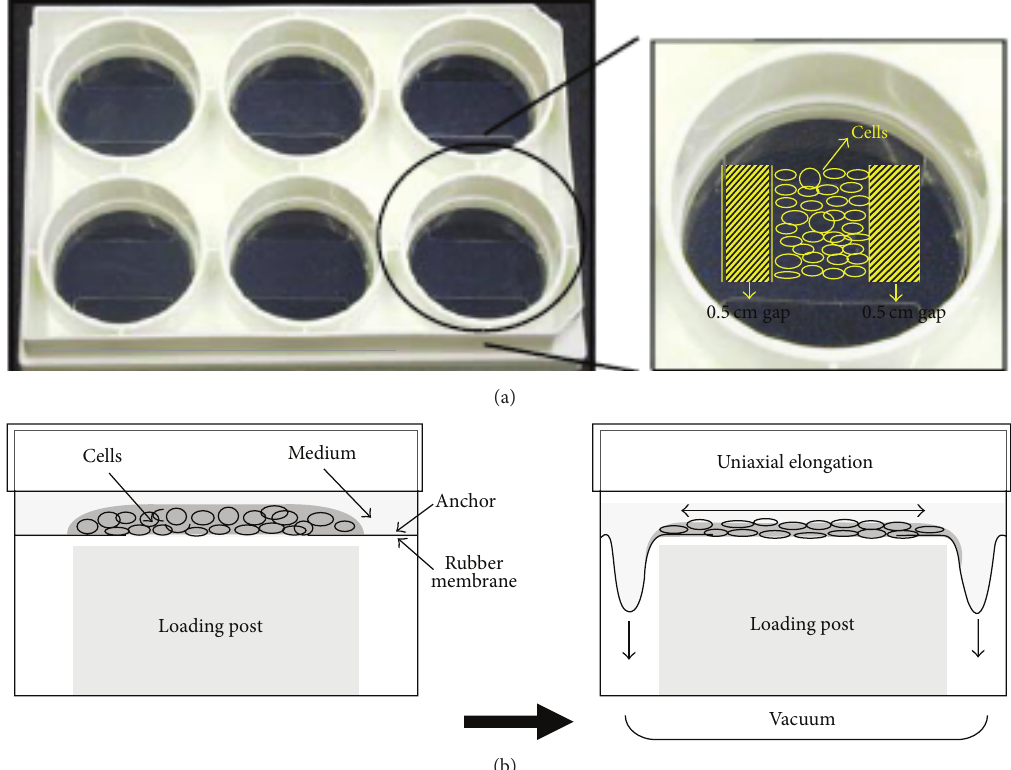
Figure 1: (a) Formation of cell sheet construct on Uniflex culture plate; (b) diagram of side view of uniaxial stretch